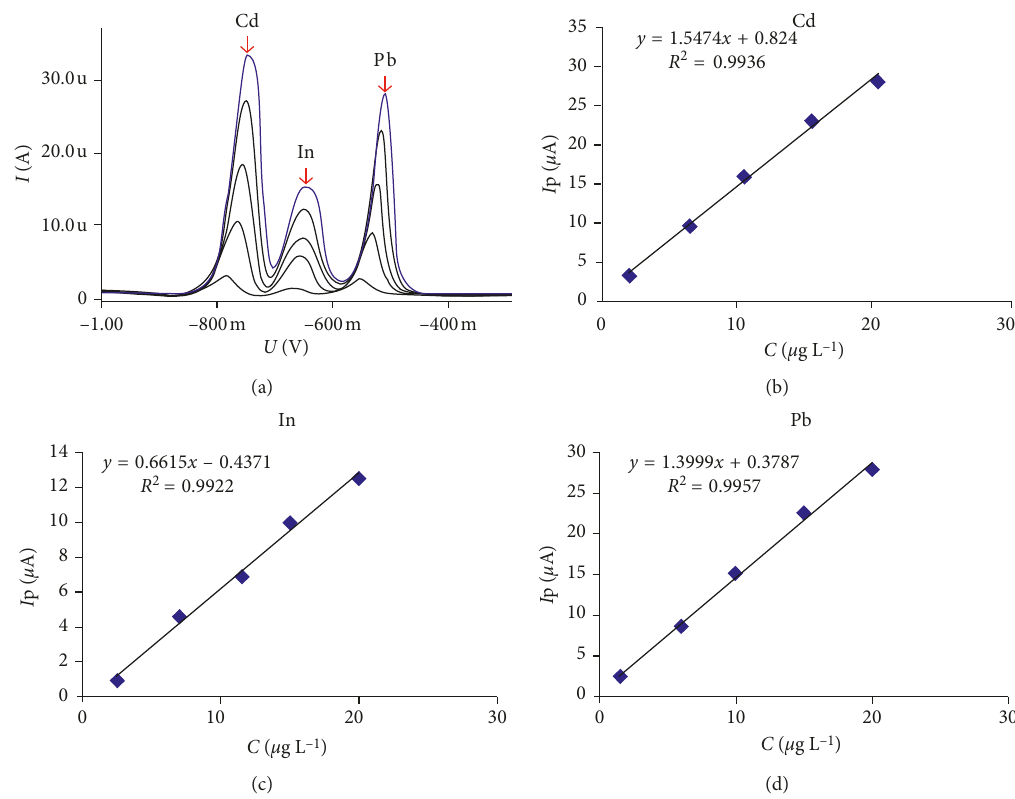
Figure 7: (a) DP-ASV of Cd(II), Pb(II), and In(III) and the calibration curve of (b) Cd(II), (c) In(III), and (d) Pb(II). Conditions: [Pb(II)]; [Cd(II)] � 1.5, 6, 10, 15, and 20 μ g · L − 1 ; [In(III)] � 2.5, 7, 11.5, 15, and 20 μ g · L − 1 ; supporting electrolyte mixture of 0.1 M KI and acetate buffer. Other conditions are as in Figure 1.